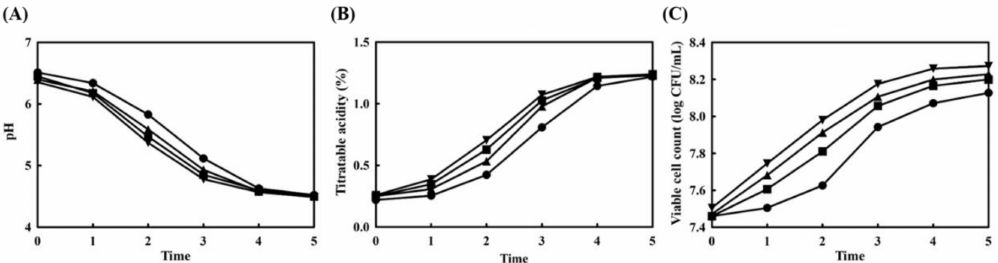
Figure 2. Change in pH ( A ), titratable acidity ( B ), and the viable cell count ( C ) of ginseng-fortified yogurts. • , control yogurt without ginseng extract; (cid:4) , 1% soil-cultured ginseng extract-fortified yogurt; (cid:78) , 0.5% hydroponic ginseng extract-fortified yogurt; (cid:72) , 1.0% hydroponic ginseng extract-fortified yogurt.